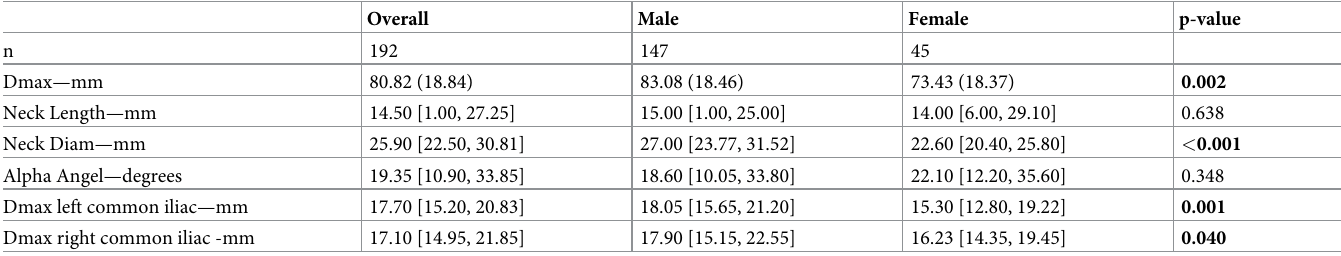
Table 2. Geometric characteristics of ruptured abdominal aortic aneurysms stratified by sex.